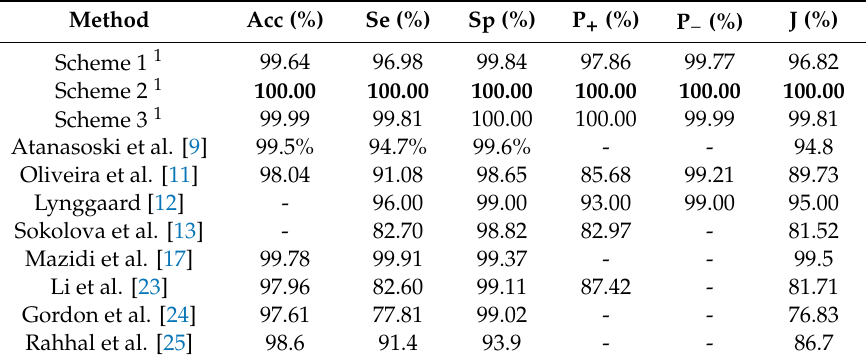
Figure 8. The confusion matrix of each scheme: ( a ) confusion matrix of Scheme 1; ( b ) confusion matrix of Scheme 2; ( c ) confusion matrix of Scheme 3. Table 9. Employ the proposed model with Scheme 2 and Scheme